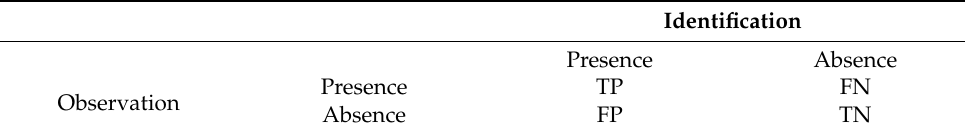
Table 3. Definitions of CG lightning identification